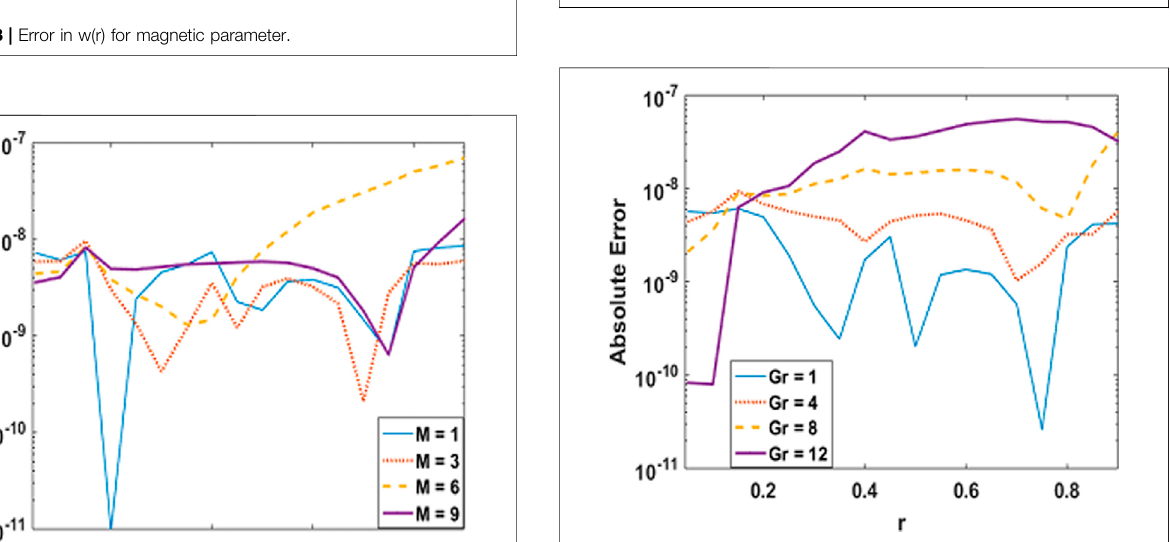
FIGURE 5 | Error in θ ( r ) for magnetic parameter.